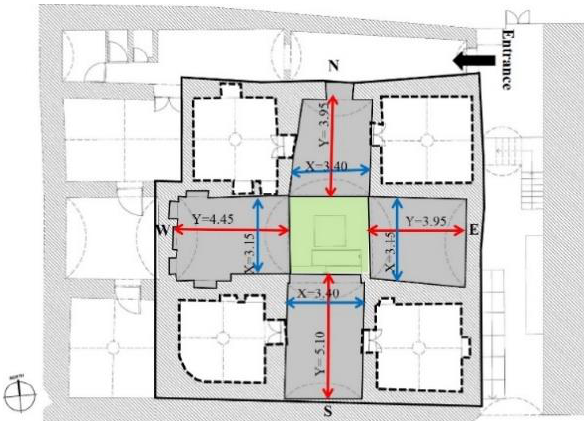
Figure 4. The proportion the length and width of the sofe in the javanmardi’s home.